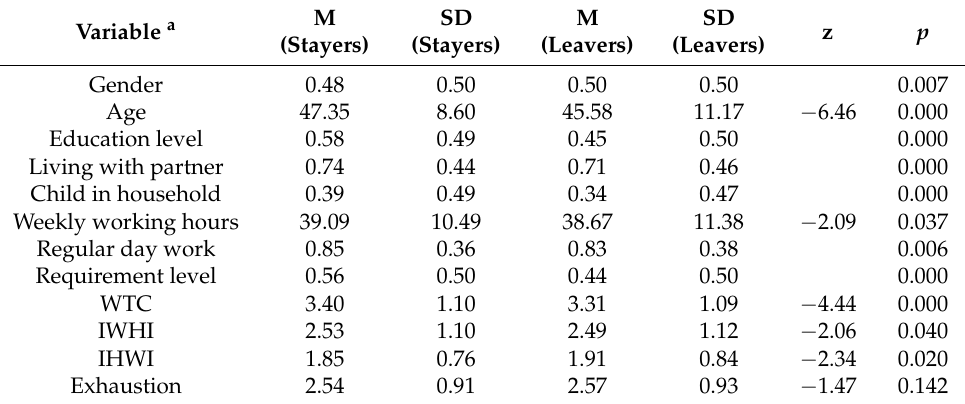
Table A3. Results from Mann-Whitney U tests and Fisher’s exact tests comparing means of study variables and control variables (both at T1) for stayers and leavers ( n for stayers = 3354–3390; n for leavers =